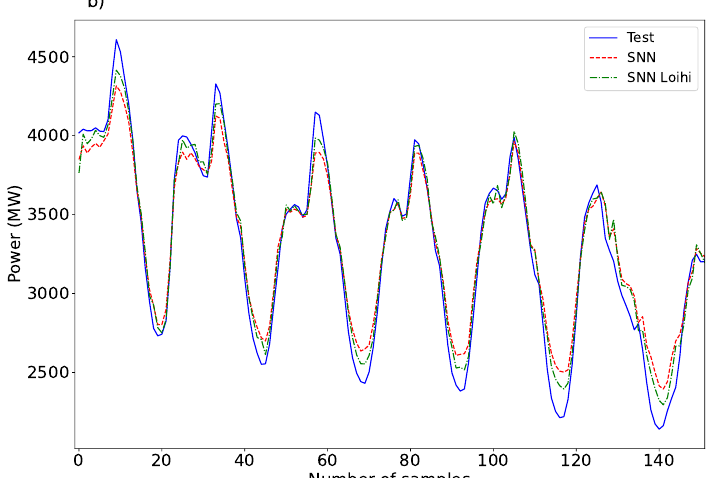
Figure 6. Results for one-step ahead load forecasts: ( a ) Neural activities of 5 neurons of each layer. One input vector is shown over 1000 timesteps. ( b ) Predictions over the testing set with the SNN architecture (dashed red line) and running the SNN on the Loihi emulator (dash-dot green